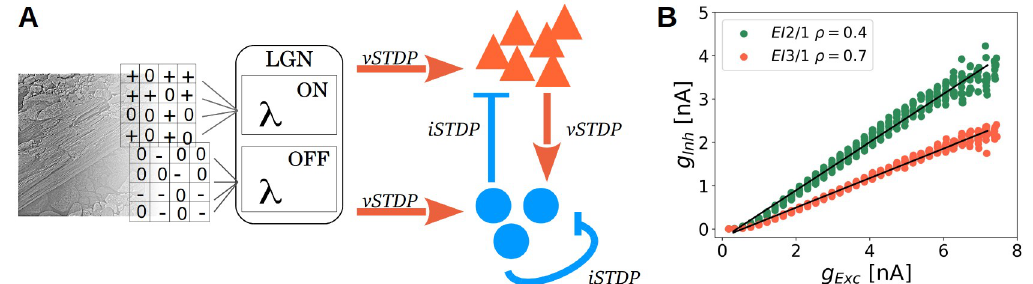
Fig 1. Network with excitatory and inhibitory plasticity rules. A Whitened image patches of size 12x12 were converted to Poisson spike trains by setting the firing rates of LGN ON- and OFF-populations to the positive and the negative part of the pixel values, respectively. Feed-forward inputs from LGN project both onto excitatory and inhibitory V1 populations, which are mutually connected. The circuit therefore implements both feed-forward and feedback inhibition. Inhibitory interneurons receive additional recurrent inhibitory connections. All excitatory synapses (orange) changes via the voltage-based STDP rule (vSTDP) [20]. All inhibitory synapses (blue) changes via the inhibitory STDP rule (iSTDP) [21]. Connectivity patterns are all- to-all. Population sizes are: LGN, 288 neurons; V1 excitatory, 144 neurons; V1 inhibitory, 36 neurons. Neurons in the LGN population show Poisson activity and are split into ON- and OFF- subpopulations. B Inhibitory currents as a function of excitatory currents, averaged across the duration of a stimulus. The post-synaptic target firing rate of the iSTDP rule ( ρ ) controls the excitation to inhibition ratio at excitatory cells. For the EI 2/1 model (green dots) a value of ρ = 0.4 leads to higher inhibitory currents than ρ = 0.7 for the EI 3/1